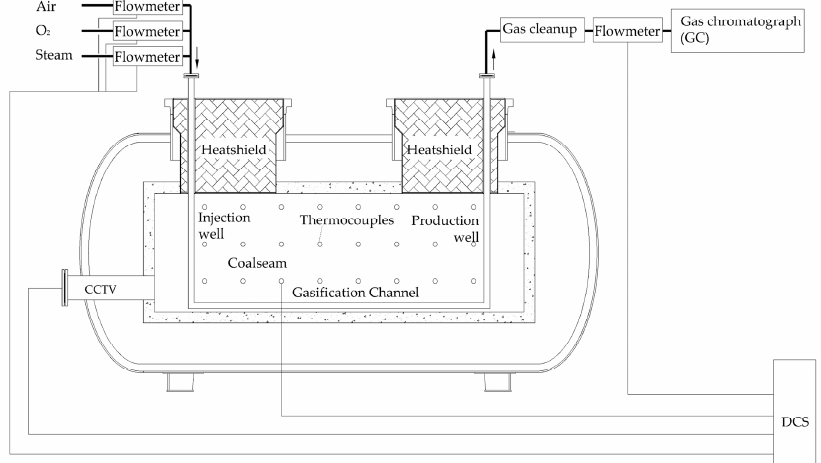
Figure 2. Schematic diagram of the UCG model test system. CCTV—closed-circuit industrial television.